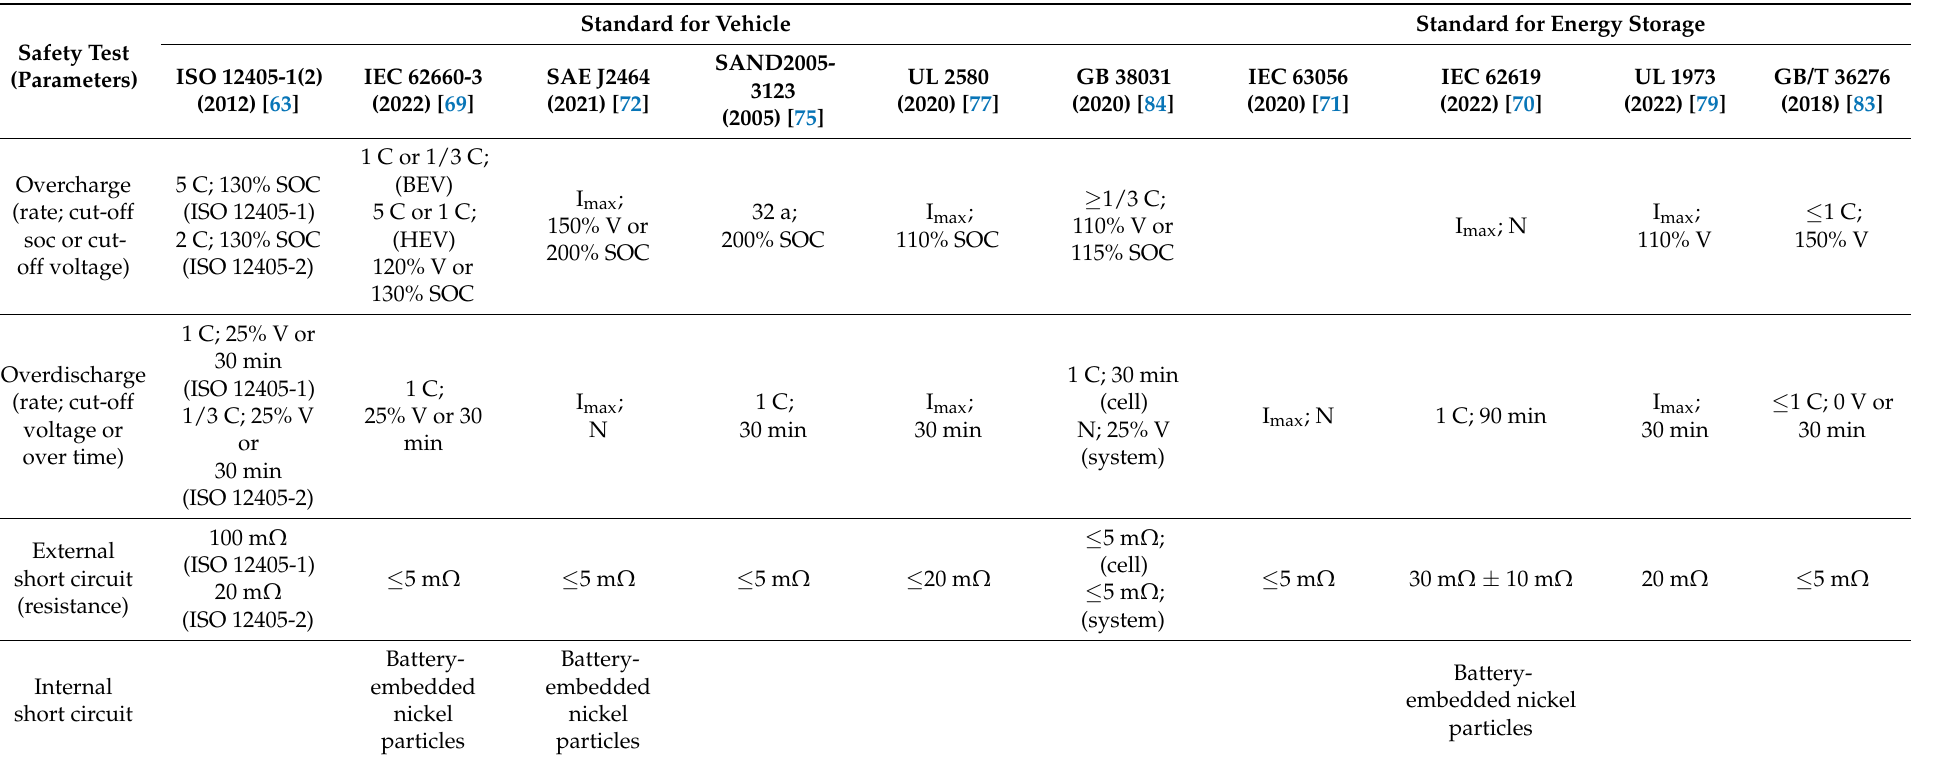
Table 5. Electrical test standards for